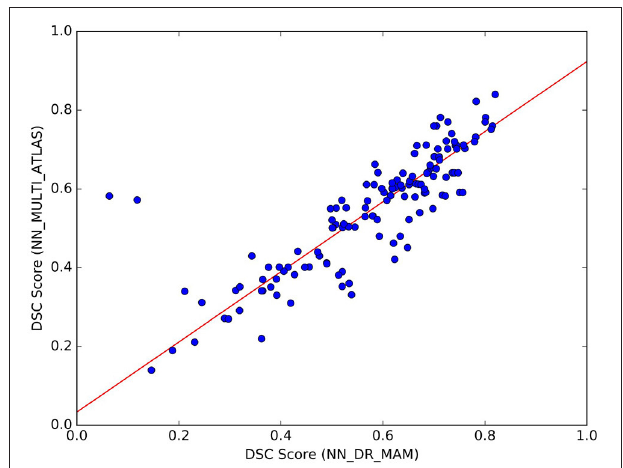
FIGURE 7 | Comparison of the results between NN_DR_MAM and NN_MULTI_ATLAS. For each of the 10 tracts of the 15 test subjects (10 × 15) = 150 points in total), the graph reports DSC computed with NN_DR_MAM (x-axis) and the NN_MULTI_ATLAS method